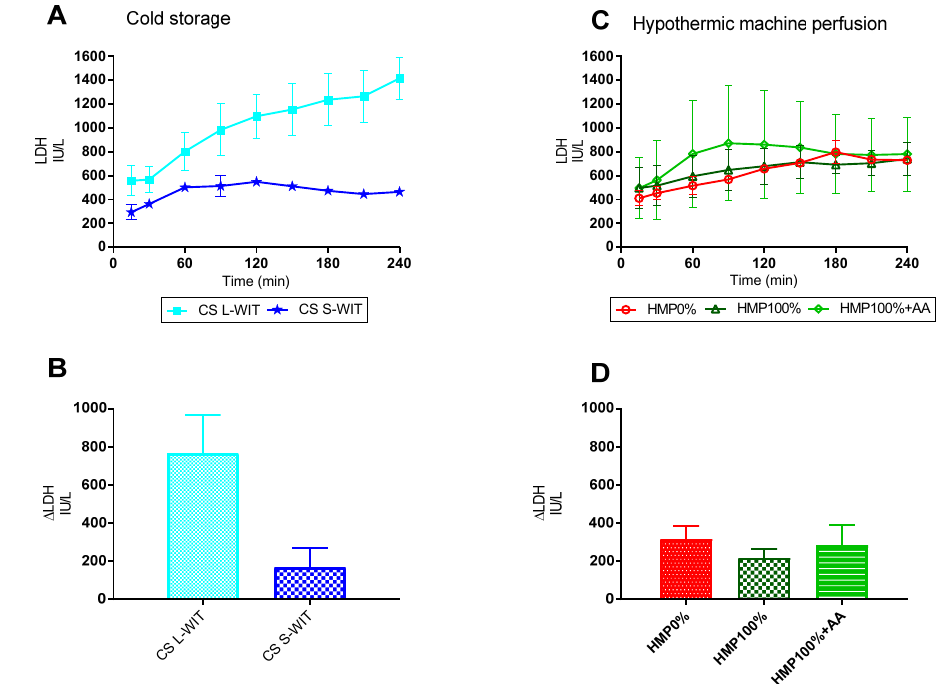
Figure 6. Kidney injury marker. Porcine kidneys perfused for 4 h with a blood-based perfusion solution to test kidney function. ( A , C ) LDH release during 4 h NKP for CS and HMP preserved kidneys, ( B,D ) delta LDH increase after 4 h NKP for CS and HMP preserved kidneys. LDH, lactate dehydrogenase; NKP, normothermic kidney perfusion; CS, cold storage; HMP, hypothermic machine perfusion. The data are shown as mean ± SD.